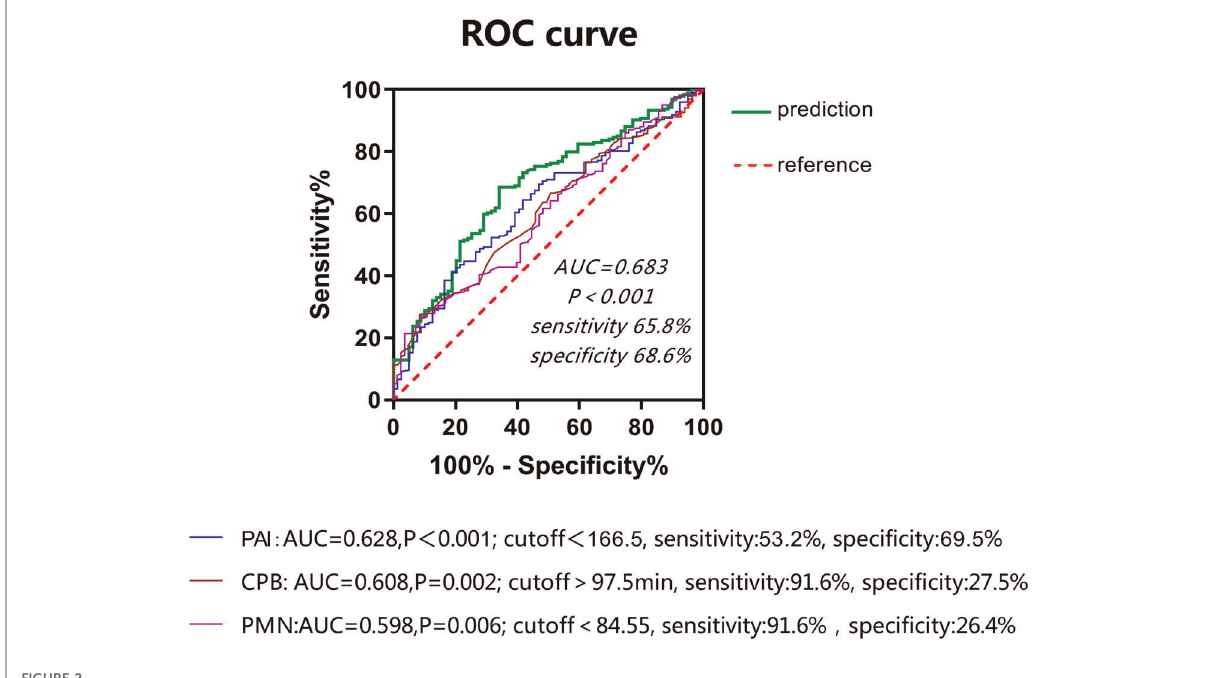
FIGURE 2 Correlation between Postoperative P/F and PMN Percentage. PMN, polymorphonuclear